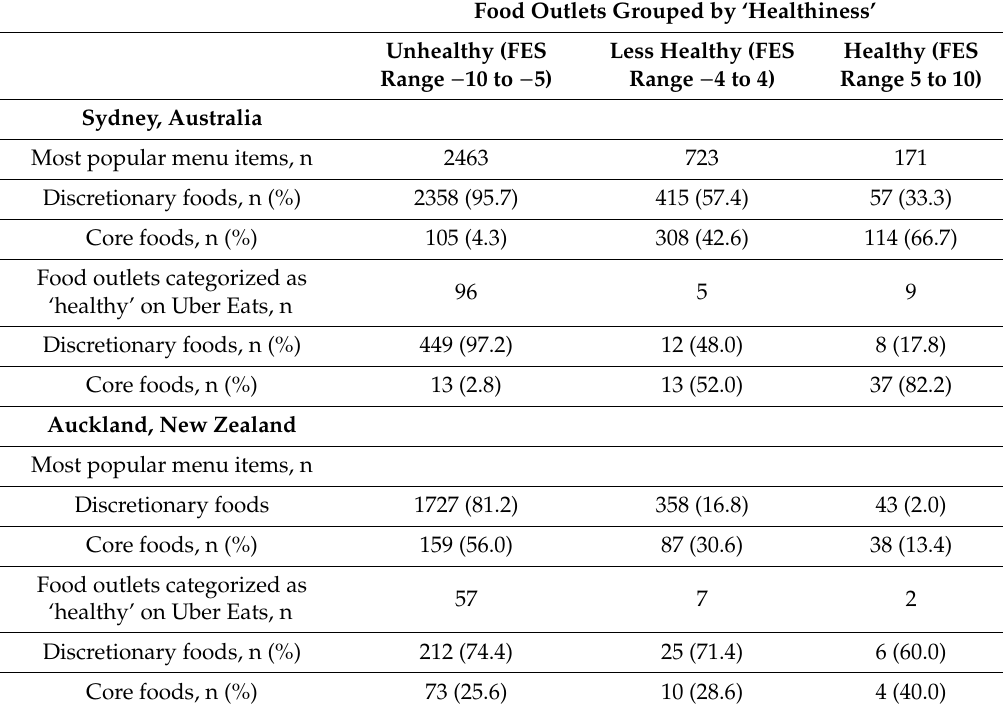
Table 3. Proportion of discretionary foods in the most popular menu items by the healthiness of the food outlet using the FES and also by the Uber Eats category of